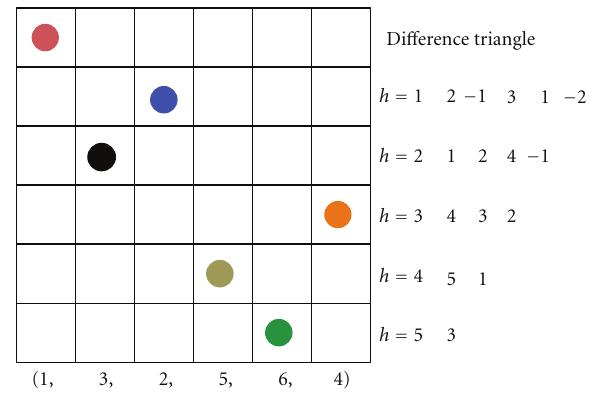
Figure 1: The Costas array (1, 3, 2, 5, 6, and 4), its matrix and permutation representations. The di ff erence triangle confirms that this is a Costas array since each row h consists of unique